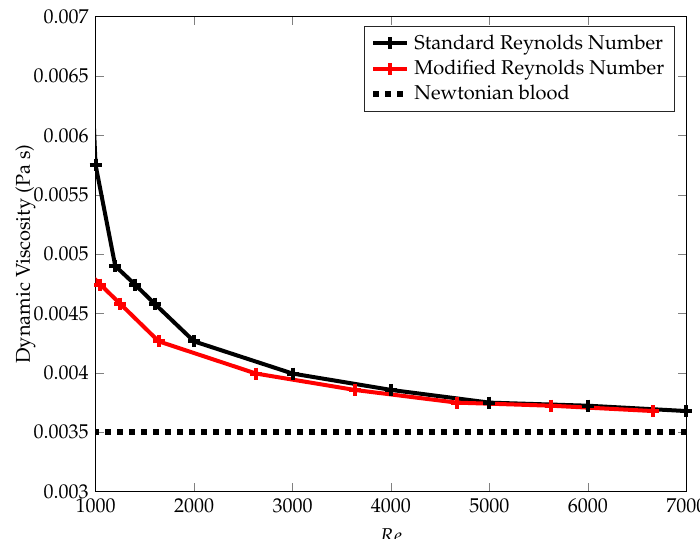
Figure 17. Computed Reynolds number based on spatially averaged viscosity with Newtonian blood viscosity (dashed line) for reference. 343